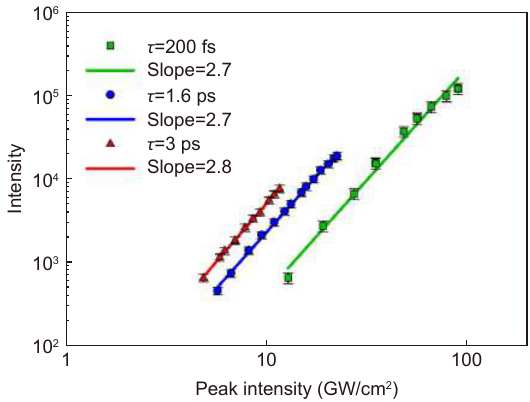
Fig. 9 | Log (fluorescence signal intensity) versus Log (incident